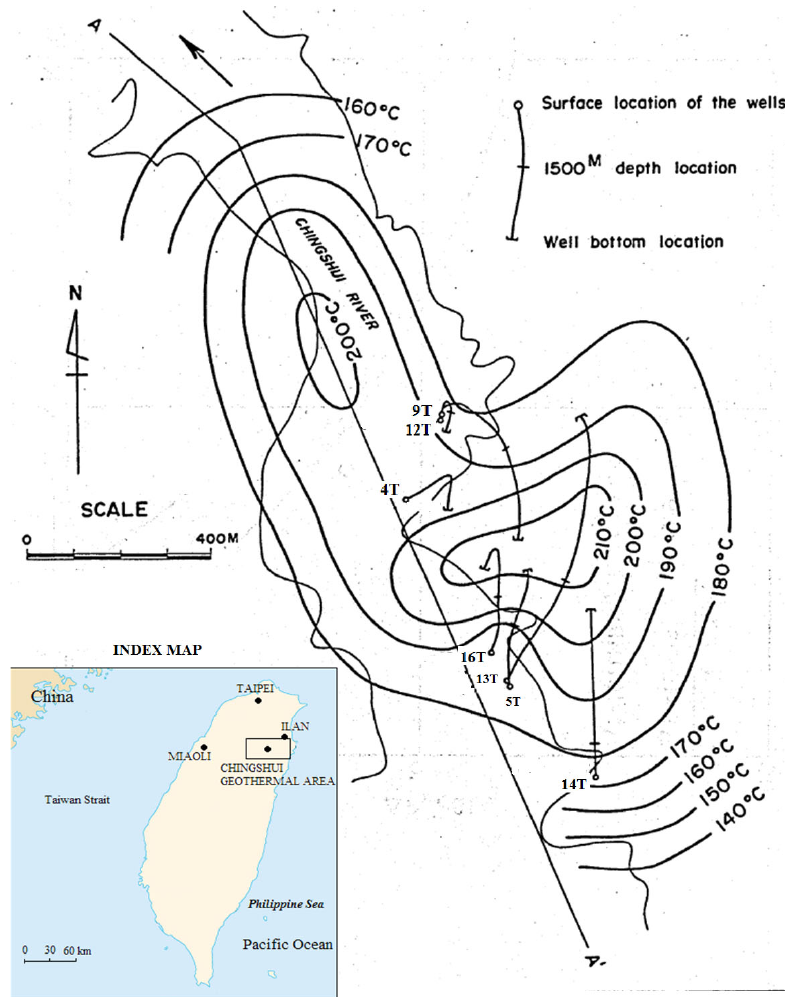
Fig. 1. Location of the CGF in Taiwan (adapted from Chang and Ramey,